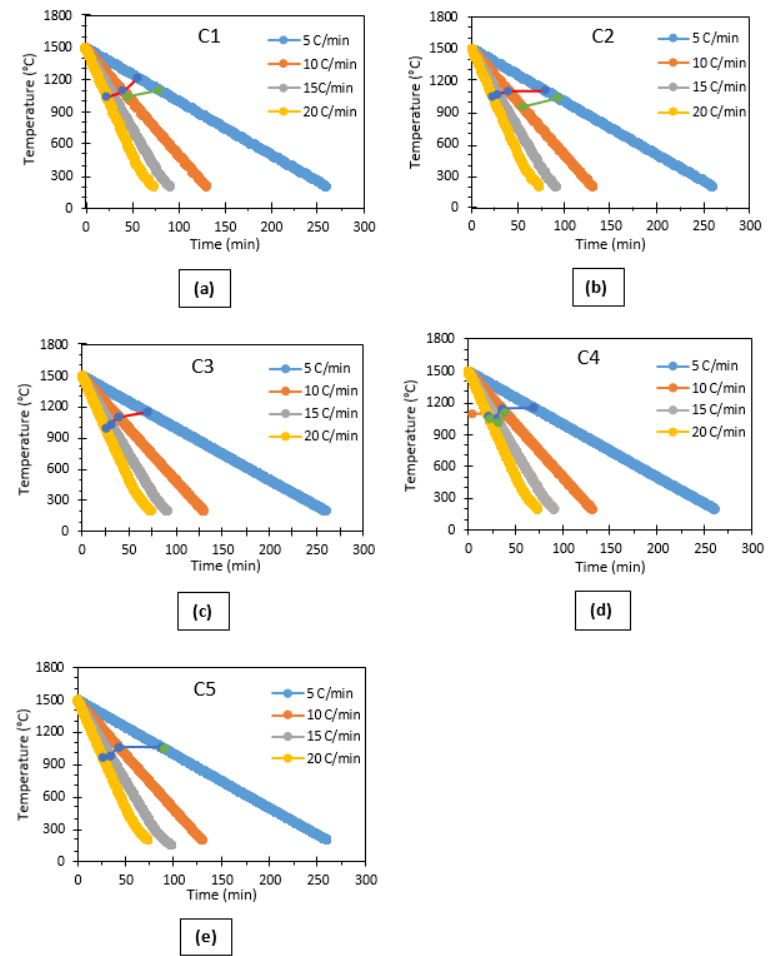
Figure 10. CCT diagrams of mould powders with different C/A ratios: ( a ) C/A = 1, ( b ) C/A = 1.5, ( c ) C/A = 2, ( d ) C/A = 2.5, ( e ) C/A = 3.